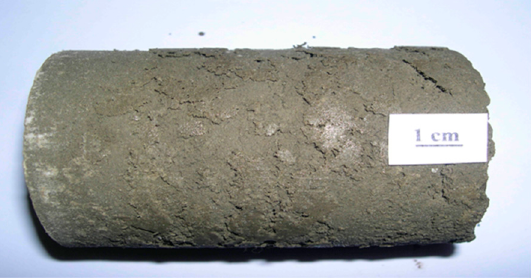
Figure 2. Frozen silty sand with massive (dissemination) pore ice and CH 4 hydrate ( W = 20%; K h = 0.42) [18].